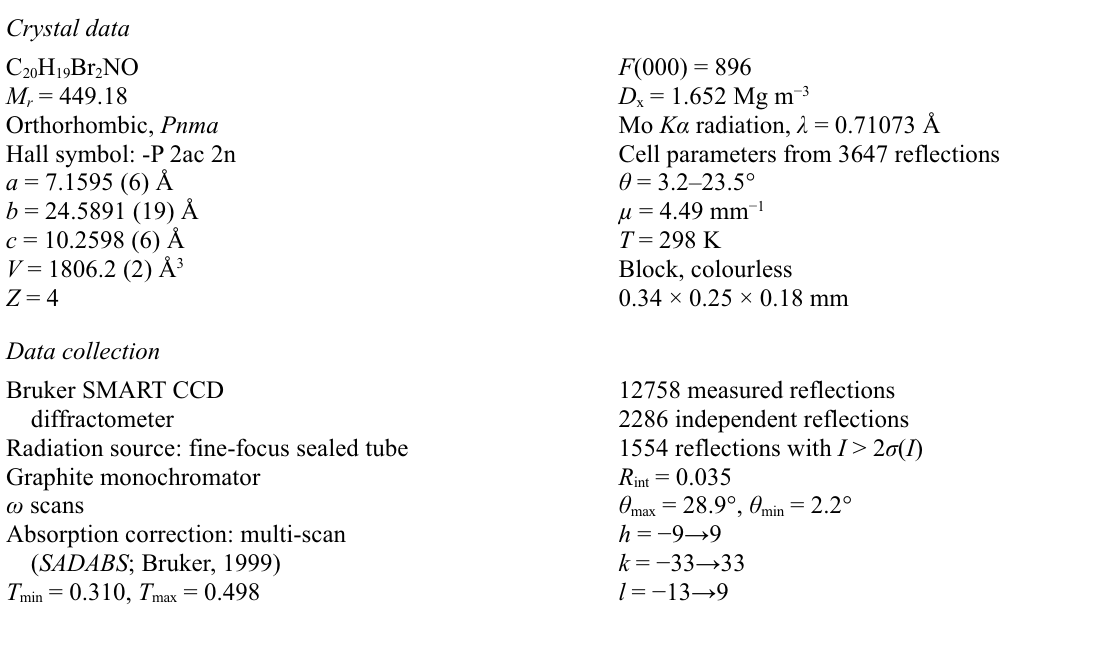
sup-3 Acta Cryst. (2008). E 64 , o2332